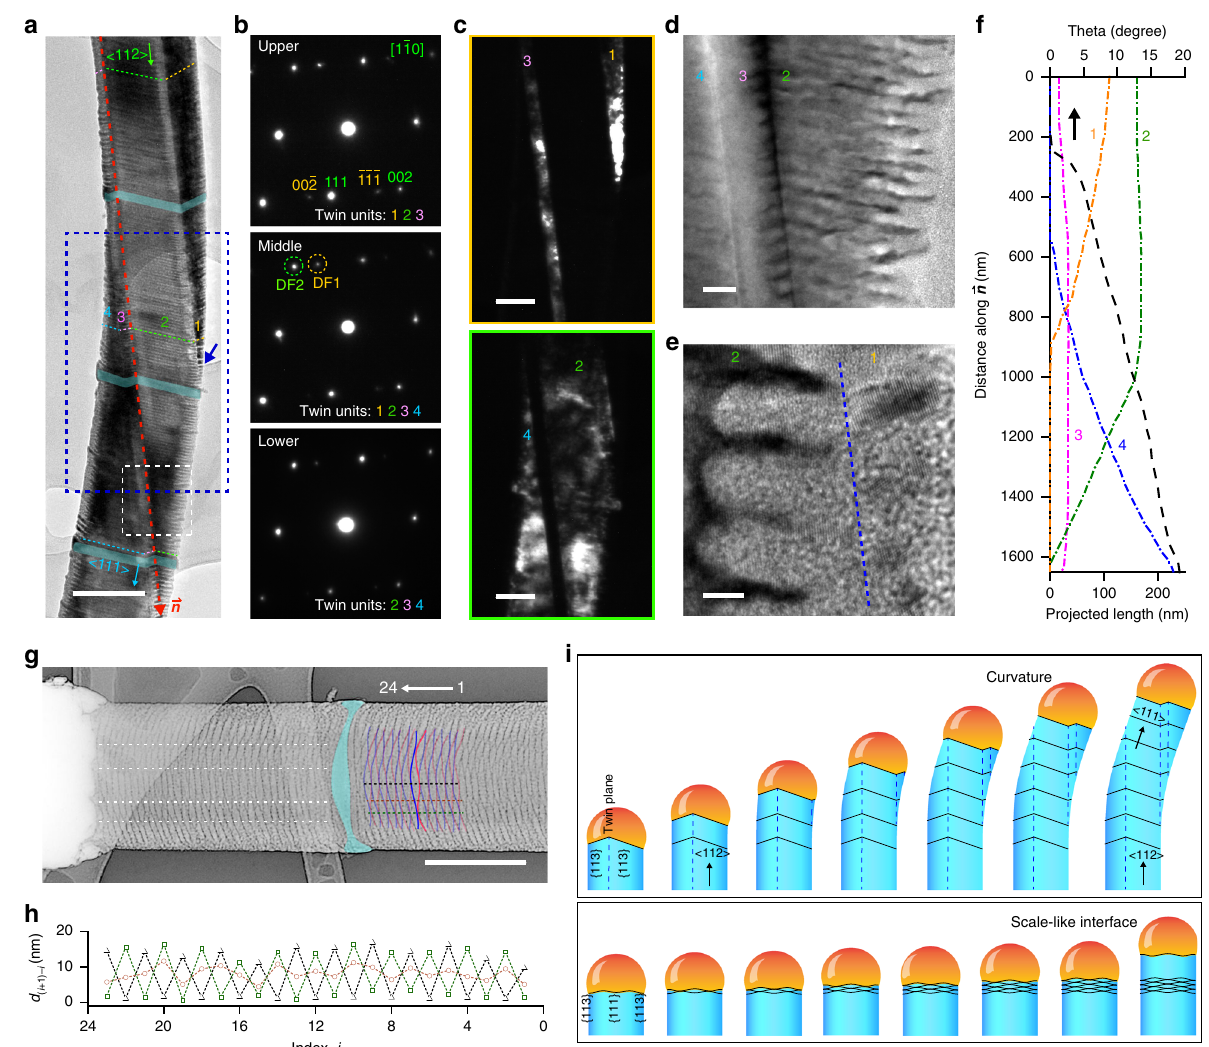
Fig. 6 Atomic gold patterns enable the discovery of new crystal growth behaviors. a A BF TEM image of the nanowire with multiple twin units labeled by numbers. The growth orientation is shifted gradually from < 112 > to < 111 > . Cyan ribbons highlight the intrinsic segments. Scale bar, 200 nm. b SAED patterns taken at upper, middle, and lower portions of the nanowire in a . c DF TEM images formed by selecting diffraction spots marked by yellow (DF1) and green (DF2) dashed circles in b . Scale bars, 100 nm. d , e HRTEM images from different regions in a , marked by a white dashed box ( d ) and a blue arrow ( e ). Scale bars, 20 nm ( d ), 5 nm ( e ). f Growth behavior analysis shows a smooth transition of the nanowire orientation from a < 112 > (marked by n a ) to a < 111 > direction. Projected lengths of individual twin units and the nanowire angular orientation are plotted along n inversion) of a nanowire with a scale-like TPB. Scale bar, 200 nm. h The growth behavior is analyzed by tracking spacing d ( i +1) – i between adjacent wavy lines (blue and pink lines) at three different locations (black, brown, and green dashed lines in g ). The white arrow in g indicates the direction of analysis. i Schematics of the growth dynamics. A curved nanowire can be formed when it gradually switches the growth orientation from < 112 > to < 111 > (black arrows), without involving a kink unit. During the transition, the droplet crosses multiple twin boundaries, marked by black dashed lines. A scale-like alloy/ Si interface is formed when the TPB oscillates between two wavy line shapes. The cyan ribbon in a and g marks an intrinsic